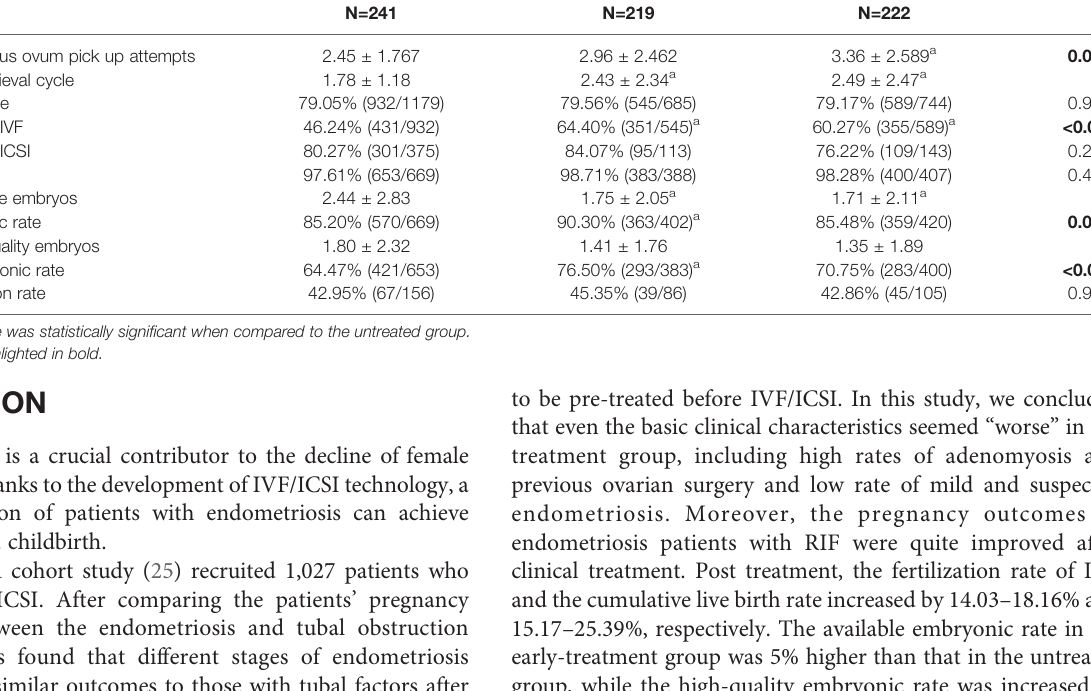
TABLE 2 | Laboratory outcomes of embryo transfer cycles of endometriosis patients with RIF. Groups